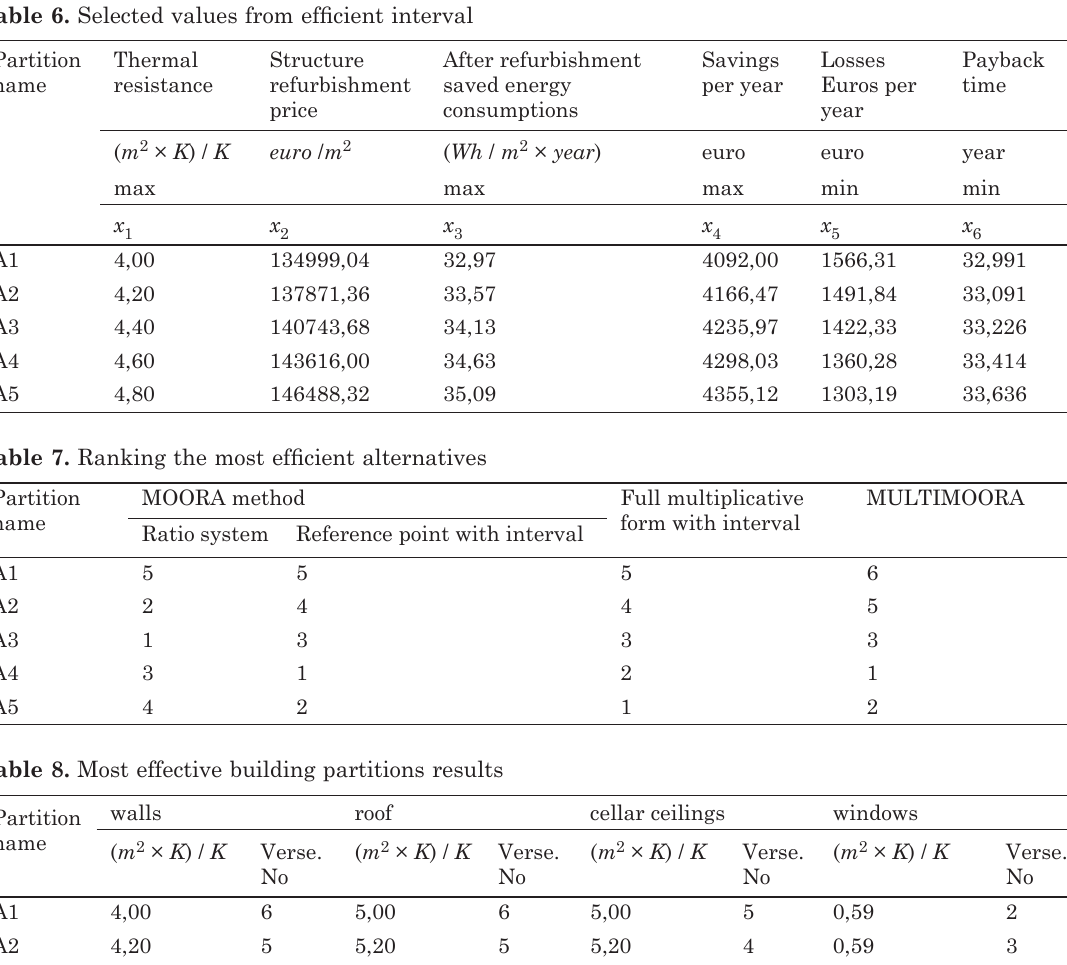
Table 5. Ranking efficient interval s 3, 4 and 5 show intermediate results of multi cri- teria calculation with intervals. We are select- ing interval between values A4 to A3. Interval upper boundary is A4 = 5.0 and interval lower boundary is A3 = 4.0. In our case it is enough to select values in two hundred precision. In the next step using multi criteria methods the most efficient alternative (see Table 6).